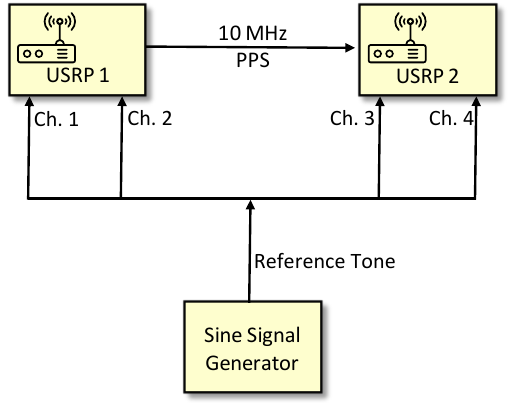
Figure 5. Phase Stability Testing Configuration: Multiple USRP, Shared GPSDO, Sinusoid Generator. The 4 channel receiver configuration captures the transmitted reference tone and then compares the received signals phase between the 4